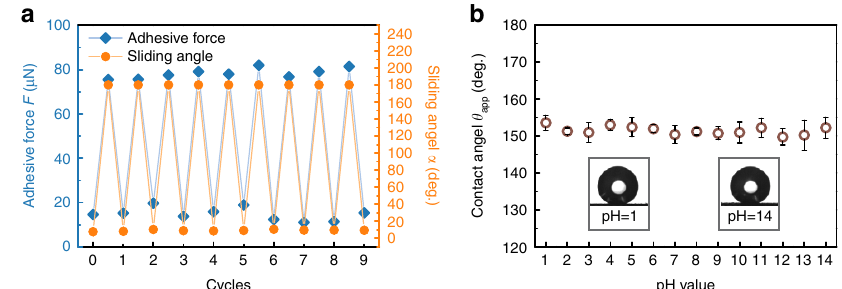
Figure 5 | The durability of an MRS. ( a ) A nine-cycle measurement of reversible switching between the adhesive and slippery states for a 4-hydrophilic- fibre MRS. For the sliding angle measurements, 5- m l water droplets were used. ( b ) The contact angle of a water droplet on an MRS remains constant for pH values varying from 1 to 14, demonstrating the excellent chemical resistance of the MRS. The error bars indicate the standard deviations over five independent measurements. The insets present the silhouettes of droplets with pH values of 1 and 14 on the